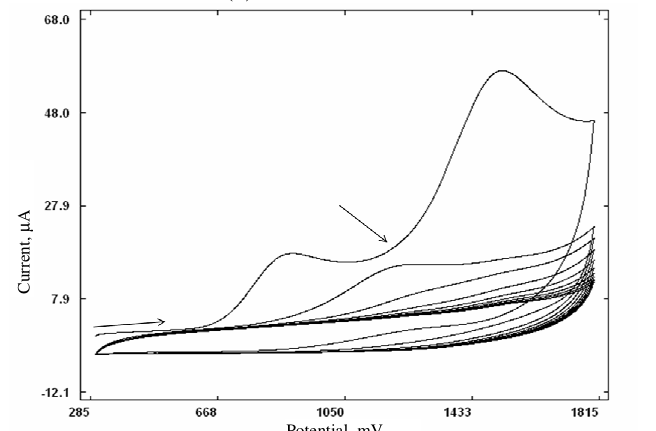
Figure 6 . Cyclic voltammogram of HIBD in the presence of 0.1 M TBATFB in acetonitrile, +0.3 V and +1.8 V potential range using 100 mV s -1 with 10